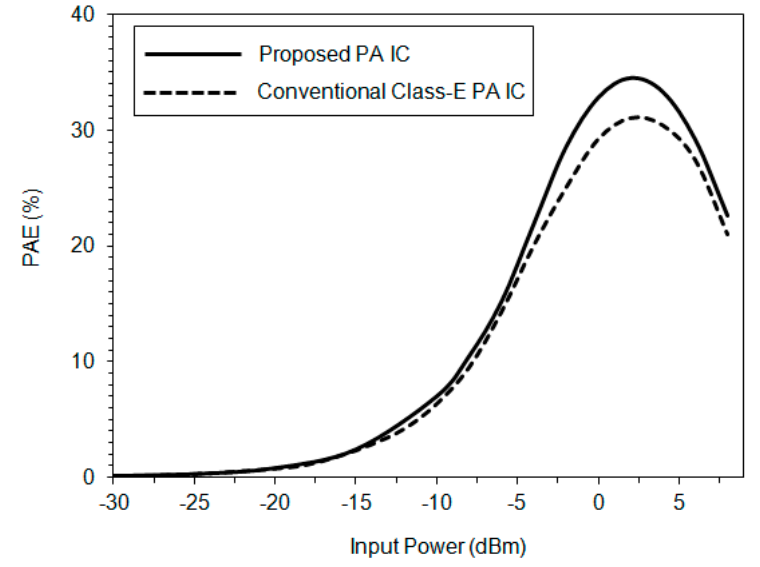
Figure 14. PAE of the proposed PA (solid line) and the conventional class-E PA (dotted line) versus the input power at a supply voltage of 1 V.